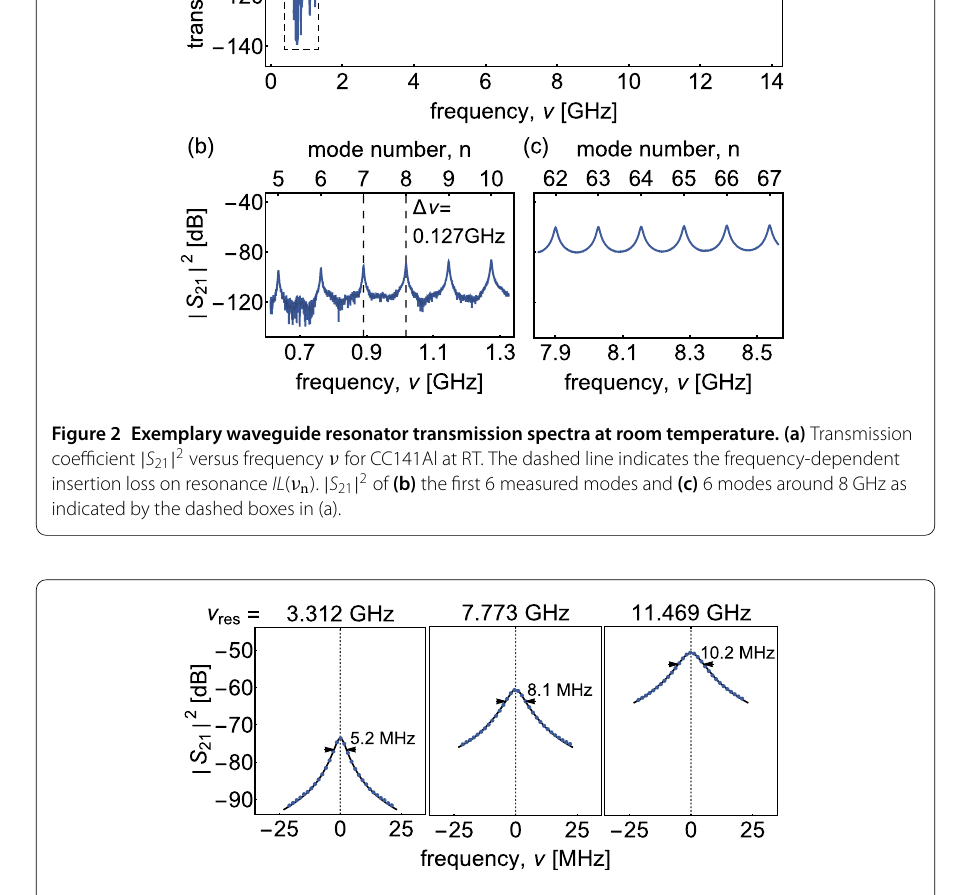
fundamental frequency ν  of a low-loss transmission line resonator is given by c  √ ν  = (cid:4)  l r with the length of the resonator l , the relative permittivity of the dielectric (cid:4) r and the speed of light in vacuum c . The internal quality factor Q i [] n π Q i =  l α